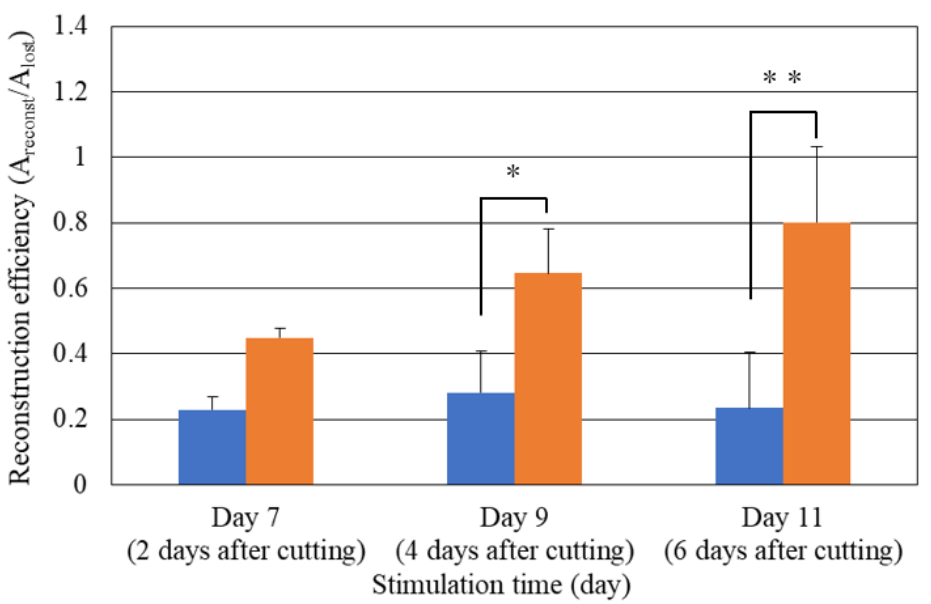
Figure 7. Comparison of reconstruction efficiency Areconst./Alost of the damaged neuronal cell colony between the statically cultured neurons and the dynamically stimulated ones (vibration ampli- tude: 60 µ m, frequency: 5 Hz, 12 h. interval) with respect to culture time according to the computed area from Figure 6. Significant differences are observed between the statically cultured damaged neurons and the dynamically stimulated ones as the culture time increases, such as 4 to 6 days after cutting damage operation.